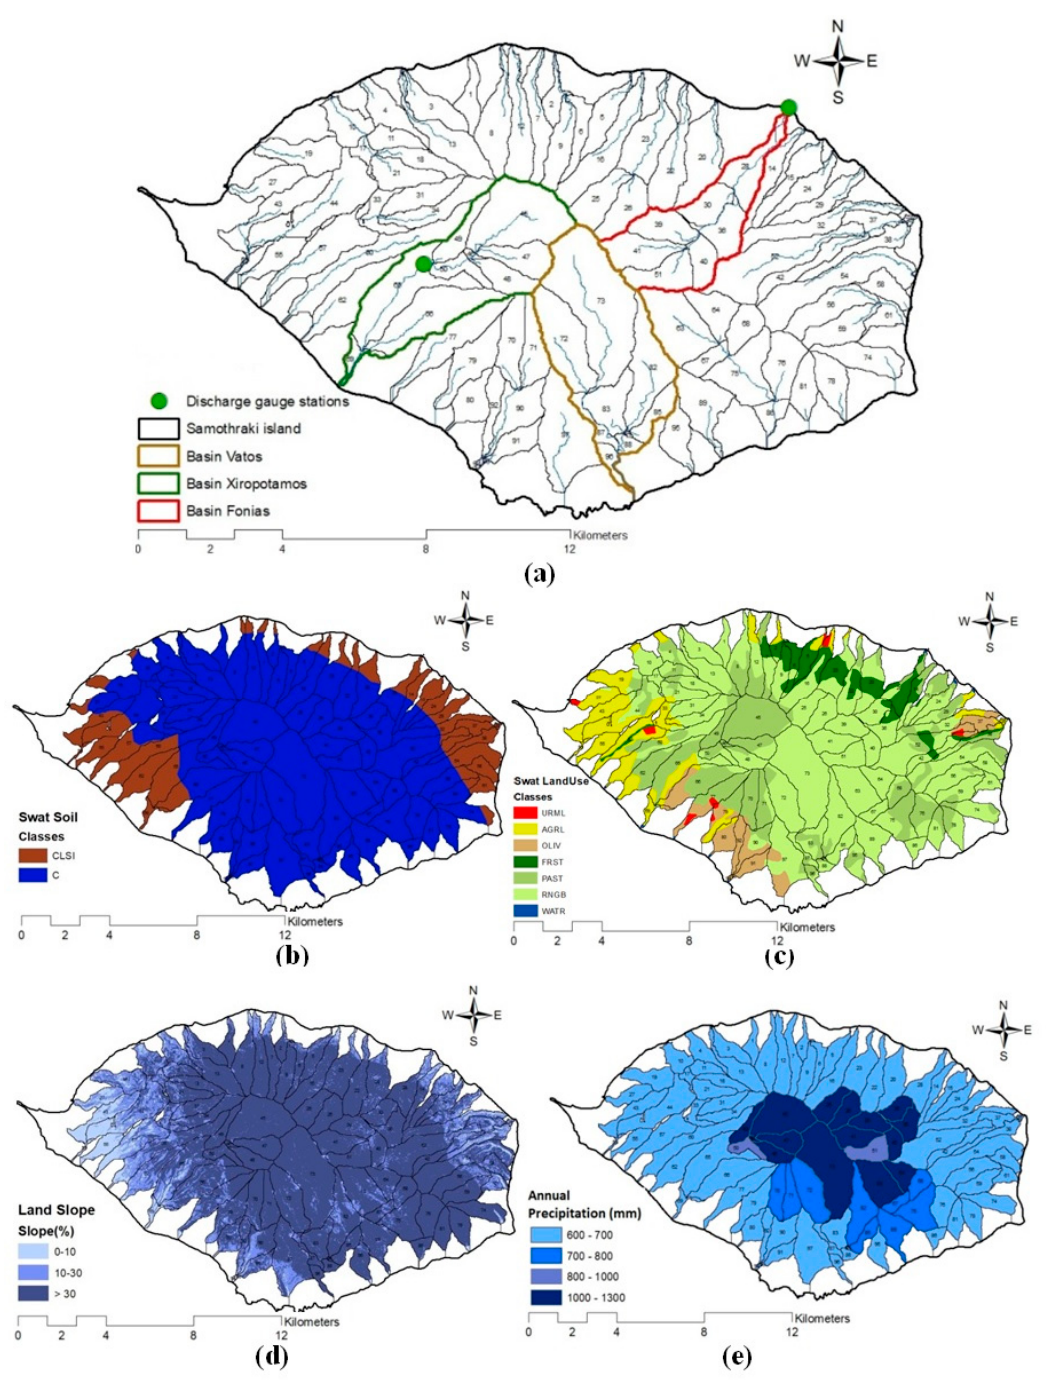
Figure 2. Samothraki island as delineated in Soil Water Assessment Tool (SWAT): ( a ) subbasins (basins of Xiropotmaos, Fonias, and Vatos are indicated) and discharge stations, ( b ) soils: silty clay loam (CLSI) and clay (C), ( c ) land-cover information, ( d ) slope classes showing the dominating steep slopes ( > 30%) in the island, ( e ) mean annual precipitation. Note: SWAT land-use classes correspond to mixed forest (FRST), pasture (PAST), rangeland (RNGB), agricultural land (AGRL), olive groves (OLIVE), low-density urban land (URML), and water areas (WATR).